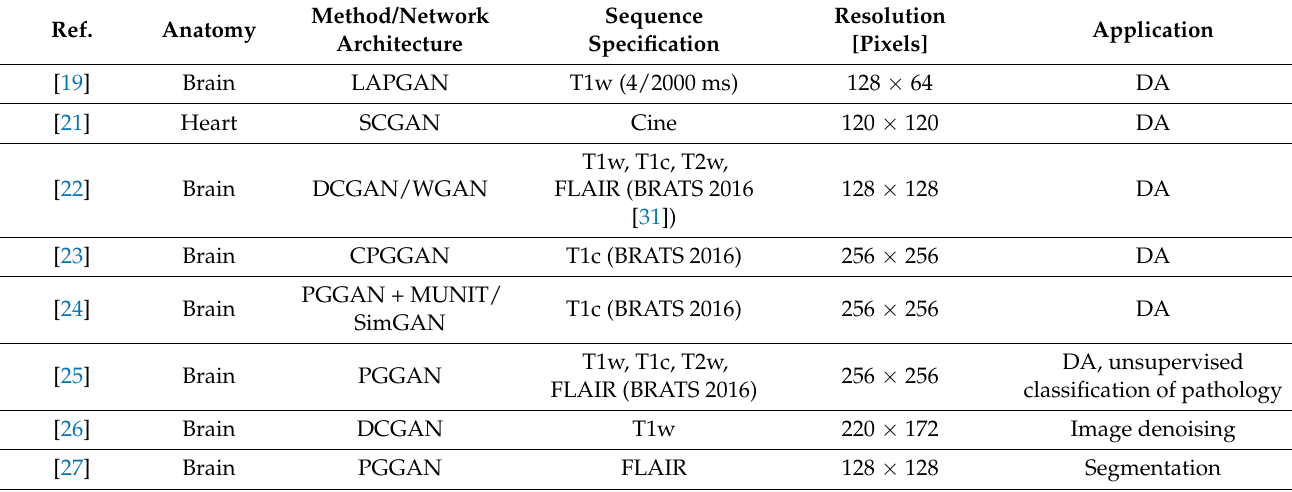
Table 1. Literature review: MR image synthesis using noise-to-image GANs.